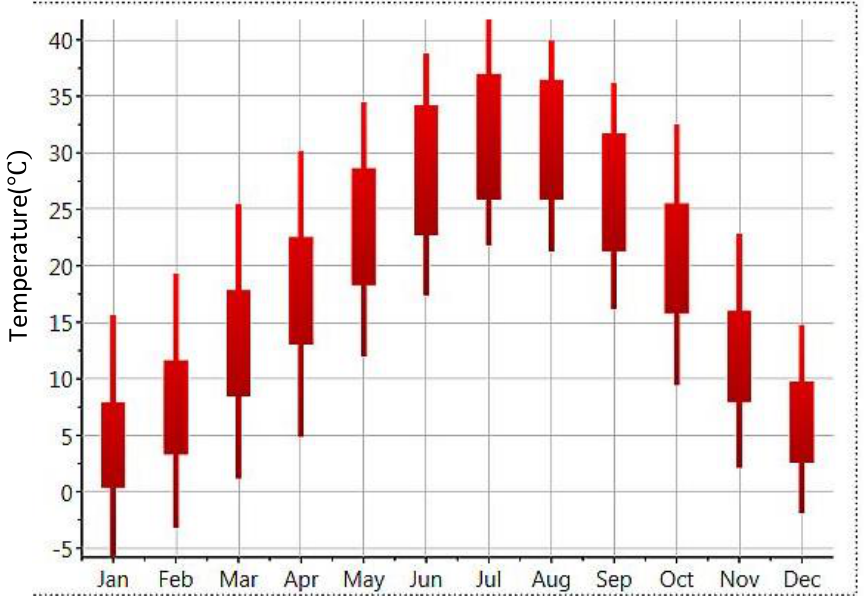
Figure 4. Map of Iran with details of the geographic location and the climate zone classification of all meteorological stations according to the Köppen climate classification.